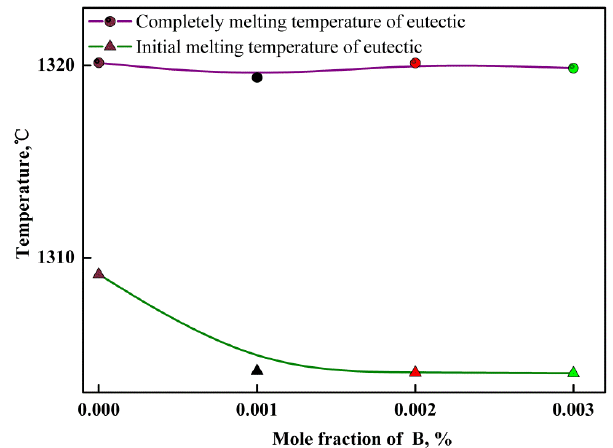
Figure 8. Influence of element B on γ + γ′ eutectic liquation reaction.